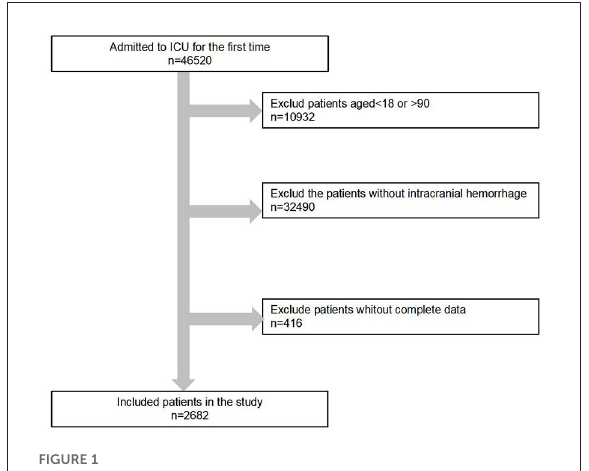
FIGURE1 The flow chart of patient inclusion in the